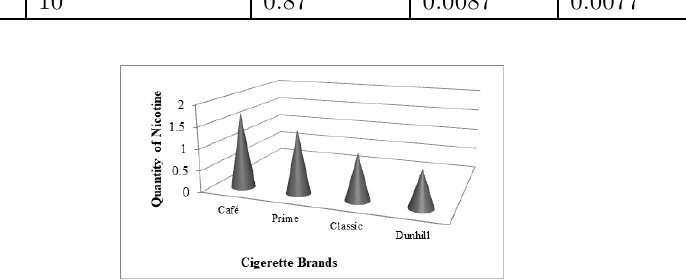
Figure 3. comparison between amounts of nicotine in different